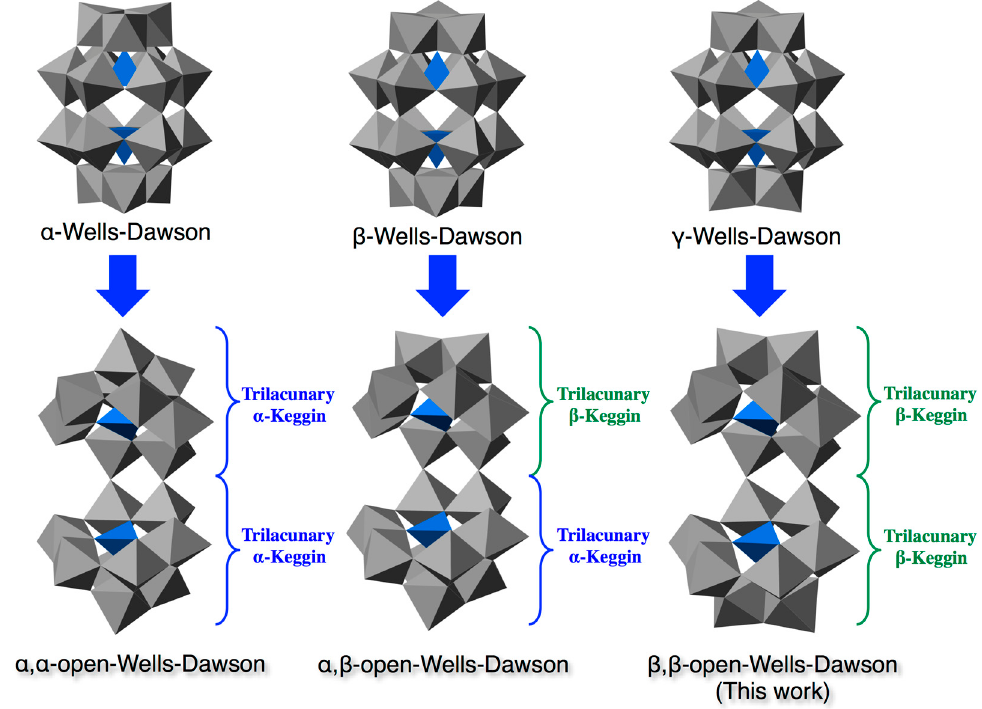
Figure 1. The isomers of the usual Wells–Dawson structural POMs and the open-Wells–Dawson POMs. Color code: XO 4 , blue; WO 6 , gray.